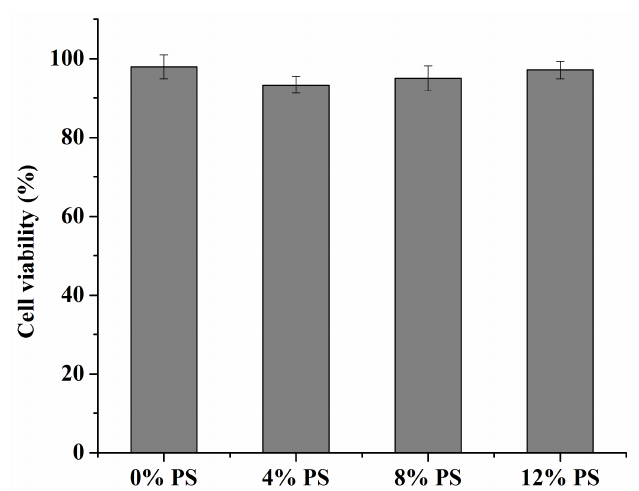
Figure 6. In vitro cytotoxicities of PS-containing Cur-mNLCs at the same concentrations as used in the cellular uptake and anti-inflammatory cell studies, with equal concentrations of curcumin (20 μ M) and carriers (expressed as solid content, about 303 μ g/mL). No significant cytotoxicity against RAW 264.7 cells was found in any Cur-mNLCs (mean ± SD, n = 3) ( p > 0.05).